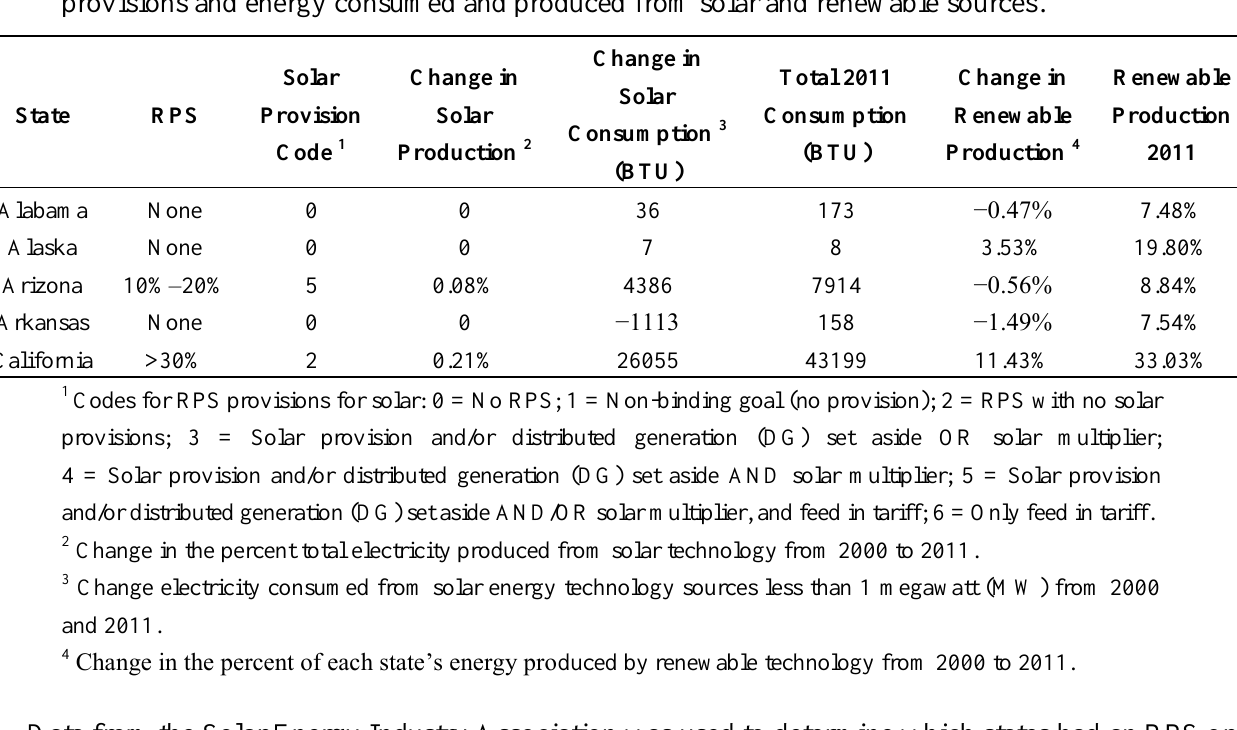
Table 1. Example table of state attributes for Renewable Portfolio Standard (RPS) provisions and energy consumed and produced from solar and renewable